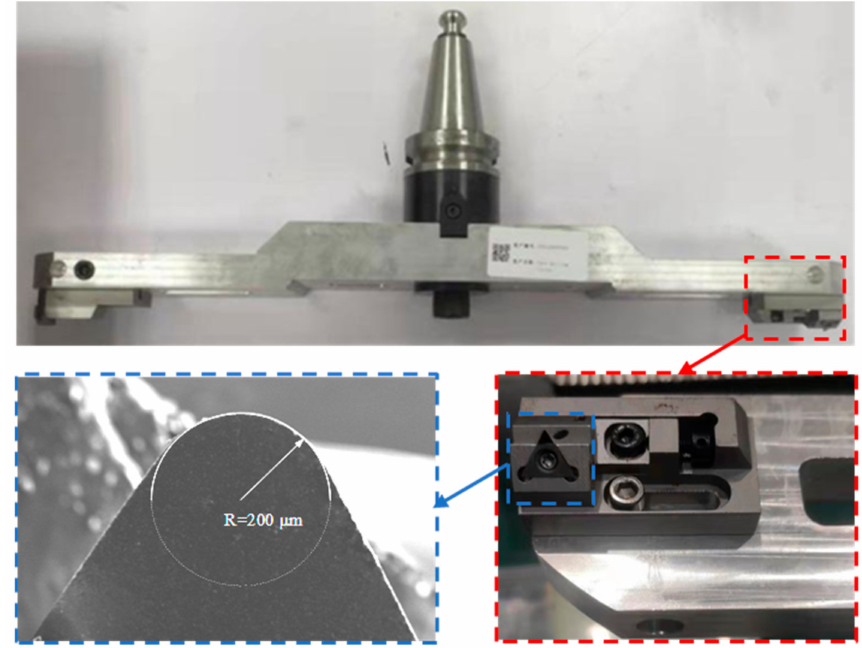
Figure 3. Specialized design cutting tool.